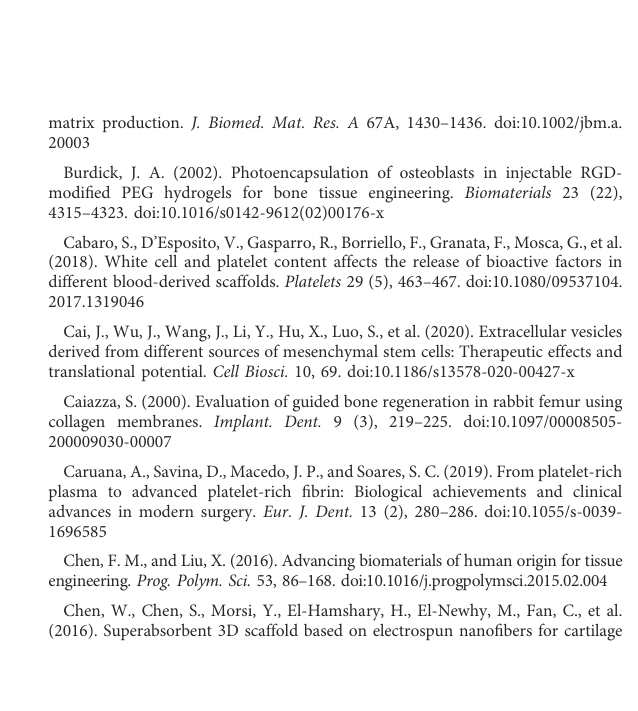
SUPPLEMENTARY FIGURE.S1 Flowchart for document processing and